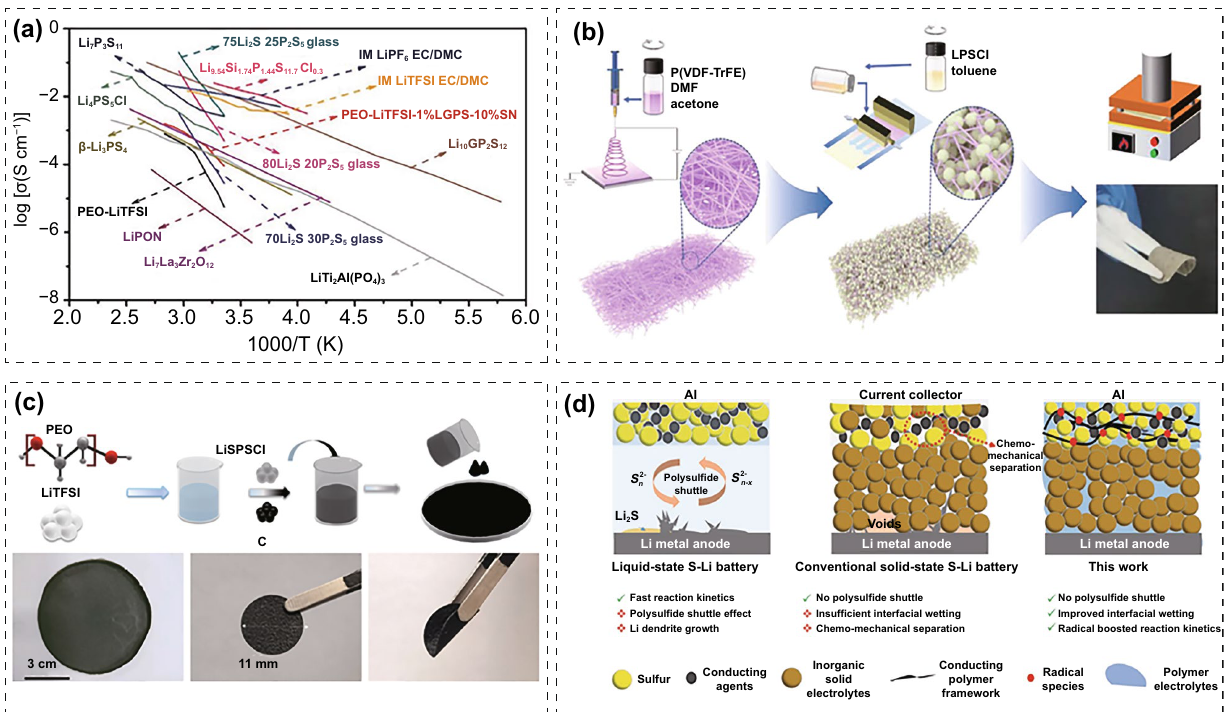
Fig. 13 a Arrhenius of sulfide electrolytes compared to organic liquid electrolytes [209]. Copyright 2019, John Wiley and Sons. b Preparation process of PIEs with Li 6 PS 5 Cl (LPSCl) and P(VDF-TrFE) by electrospinning-permeation-hot pressing method [88]. Copyright 2022, John Wiley and Sons. c Preparation process of PEO-LiTFSI@LSPSCl [211]. Copyright 2022, John Wiley and Sons. d Comparison of S||Li batteries oper- ated in liquid electrolytes, ceramic solid-state electrolytes and PIEs [212]. Copyright 2020, John Wiley and